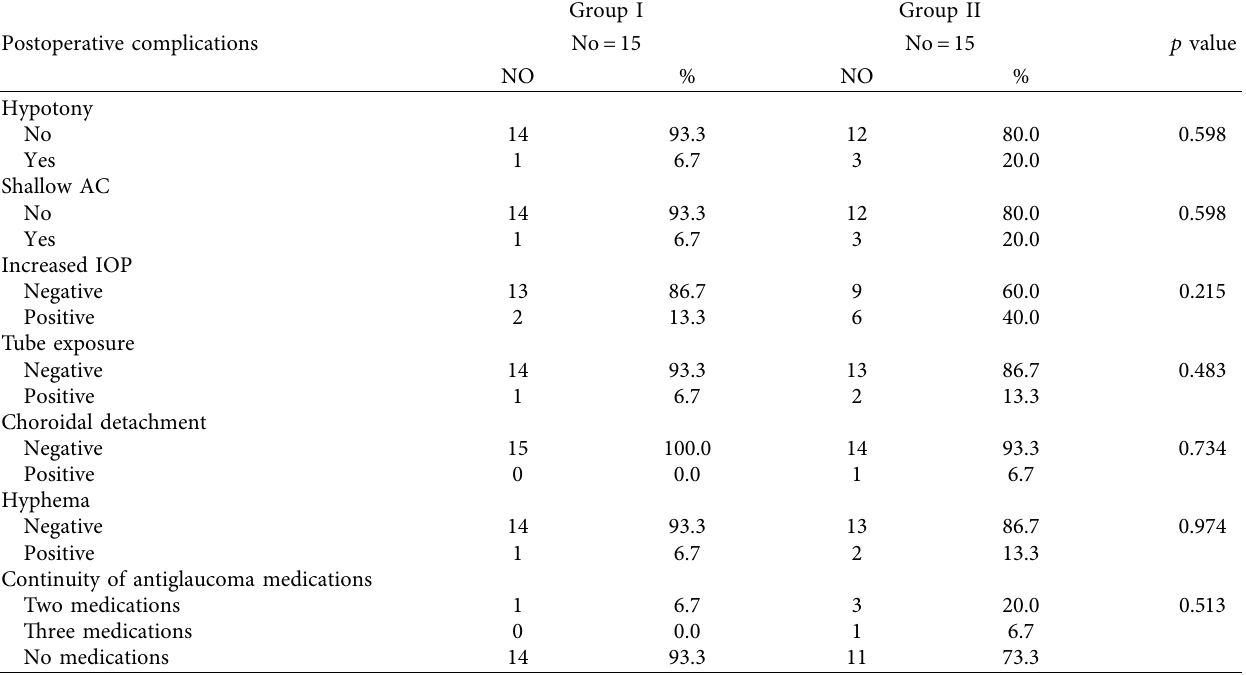
Table 3: Postoperative complications of the studied groups.